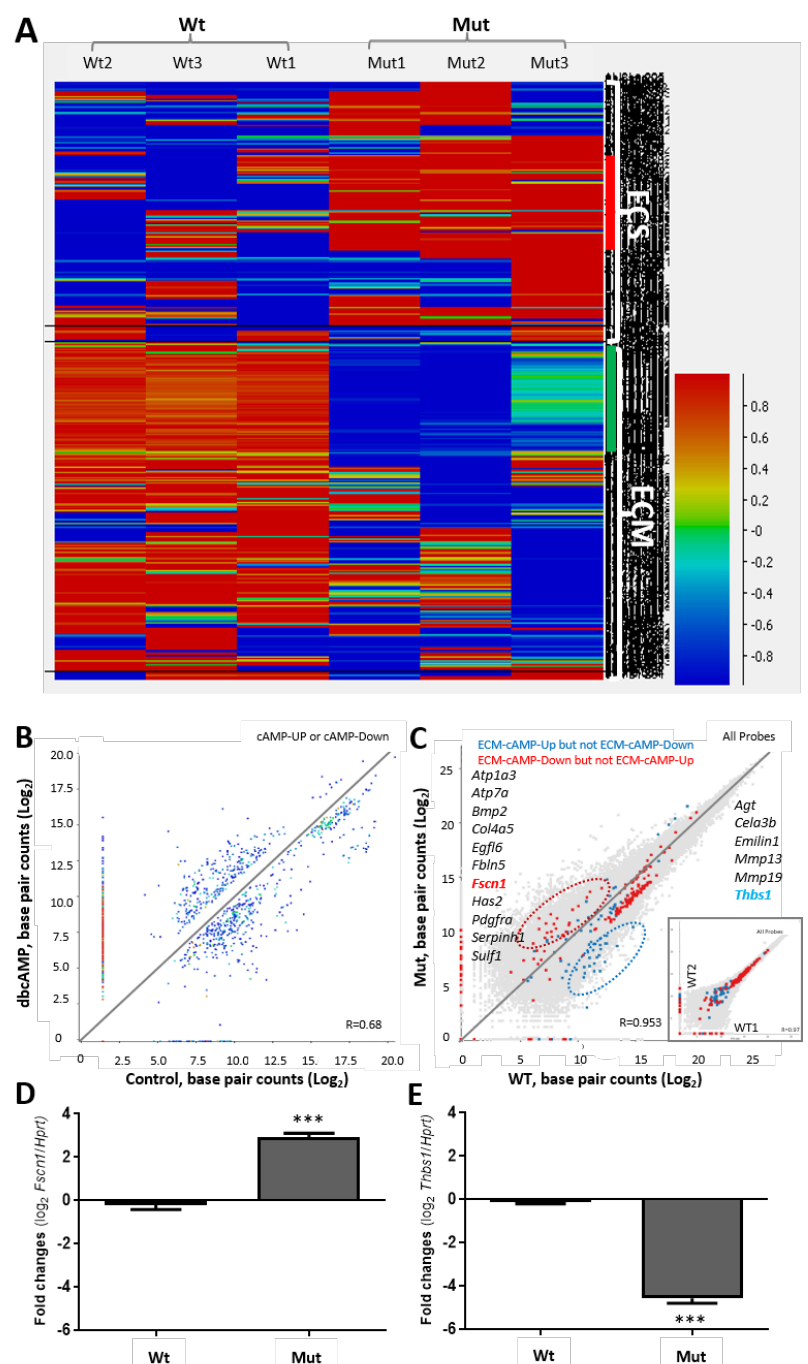
Figure 3. The disturbed expression of ECM and/or ECS genes after Tspo mutation in Mut cells. ( A ). Hierarchical cluster analysis of top functional groups of genes with either down- or up-regulation. The dramatic changes of the up-regulated extracellular structure organization (ECS) genes and the down-regulated extracellular matrix organization (ECM) genes are highlighted in hierarchical clustered heat maps from red (high) to blue (low), vertical bar. ( B ). Selected ECM and ECS genes in Wt cells from the hierarchical cluster analysis are distributed randomly in response to dbcAMP treatment. The diagonal line in the figure separates the gene expression further into high (up-left) or low (low-right) responses to dbcAMP. The colors of the dots correspond to the colors assigned to the genes from the hierarchical cluster analysis above. Color spots along either the x- or y- axis are unreadable exon(s). ( C ). Unique up- (in red) or low (in blue) expression of the ECM and ECS genes in response to TSPO depletion under dbcAMP treatment. Insert, the two Wt cell lines are compared. An example from either up- and down-regulated genes (Fscn1 vs. Thbs1) is highlighted. ( D , E ). Real-time PCR of the two genes: Fscn1 versus Thbs1. ***, p value < 0.001 (student t -test, n =